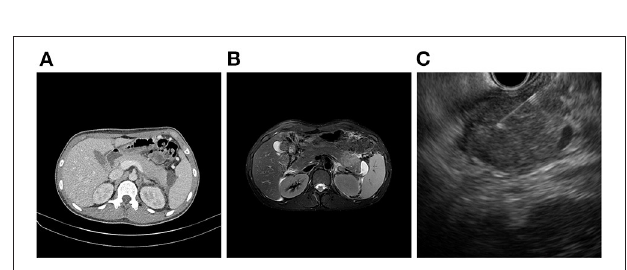
FIGURE 2 | Images of (A) abdominal CT, (B) magnetic resonance imaging and (C) EUS-guided FNA.